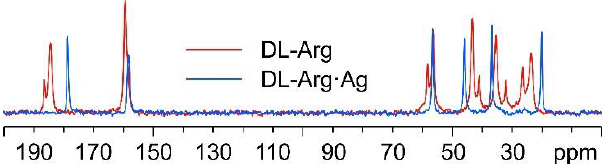
Figure 7. Overlay of the 13 C CPMAS spectra of DL-Arg·Ag (in blue) and pure DL-Arg (in red).